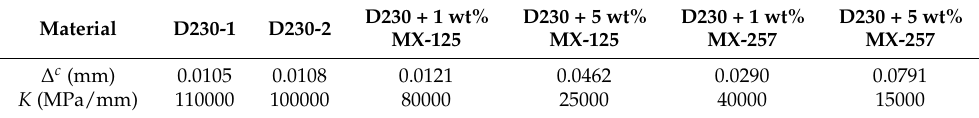
Table 4. Parameters for surface-based cohesive zone (CZS) simulations using a linear TSL (c =